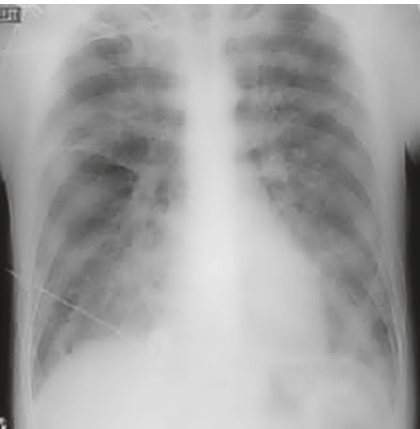
Figure 1: Chest radiograph showing pulmonary edema with normal cardiac area.